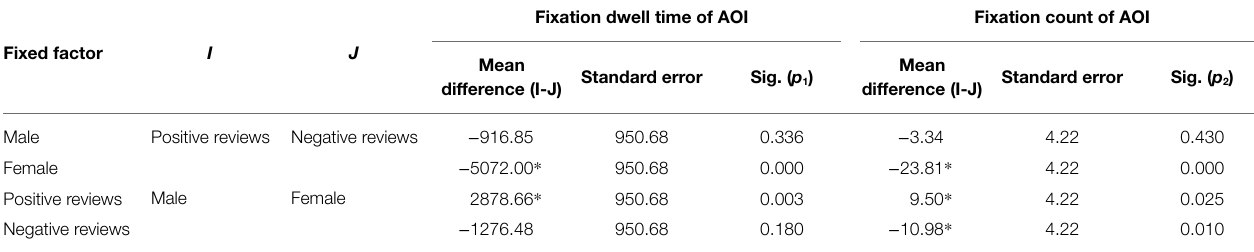
TABLE 3 | Results of simple-effect analysis.